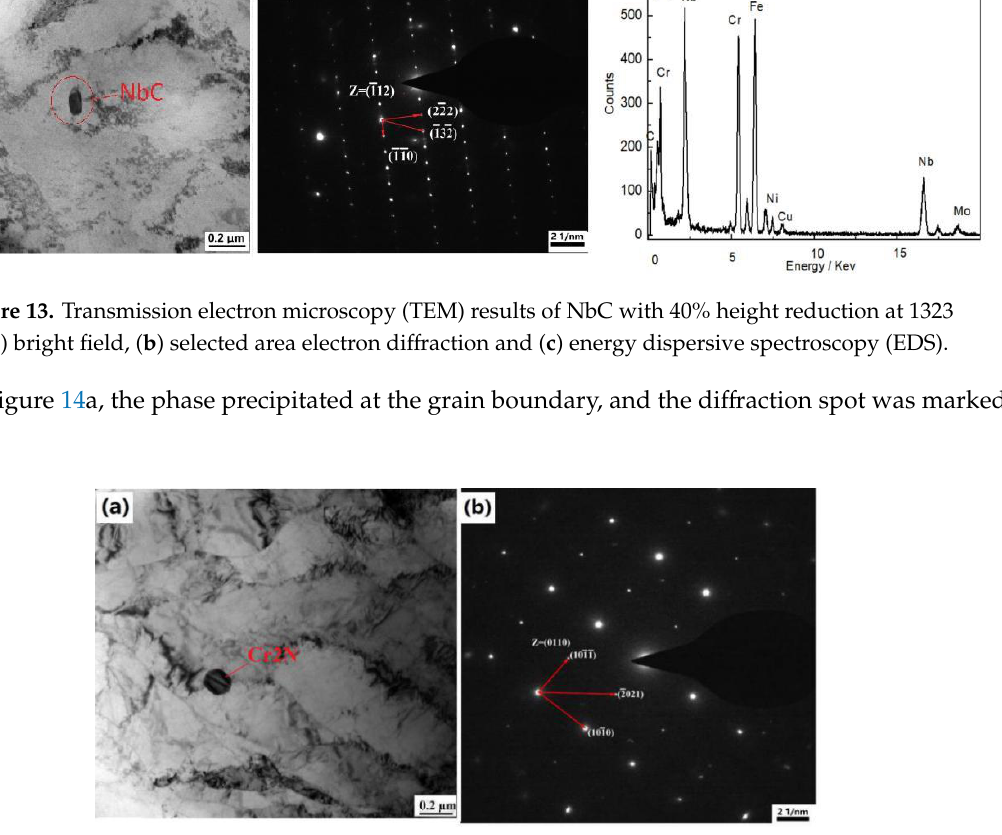
Figure 14. TEM results of Cr 2 N: ( a ) bright field and ( b ) selected area electron di ff